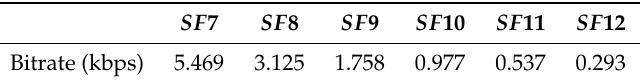
Table 4. Spreading factors and